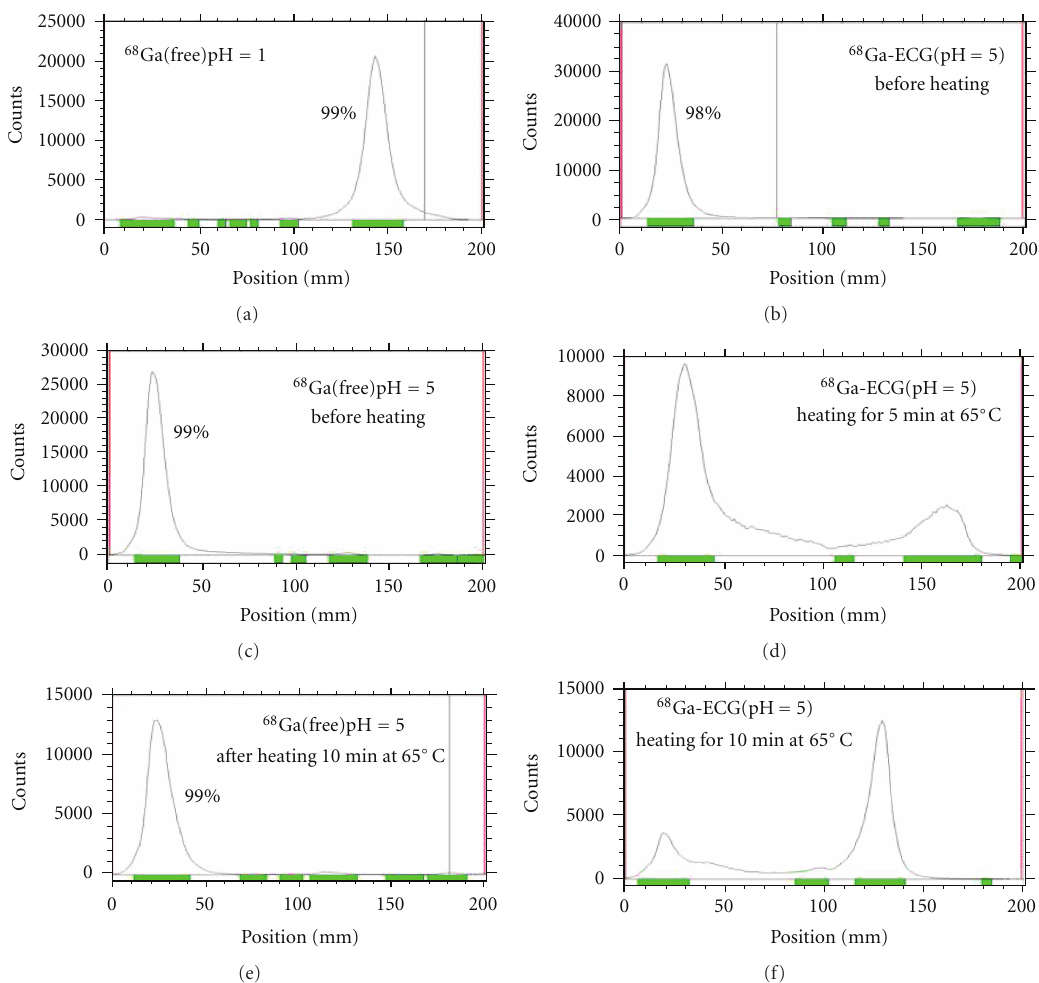
Figure 2: TLC analysis of 68 Ga-ECG using saline as an eluant. Radio-TLC analysis of the purity of 68 Ga-ECG was > 96%.